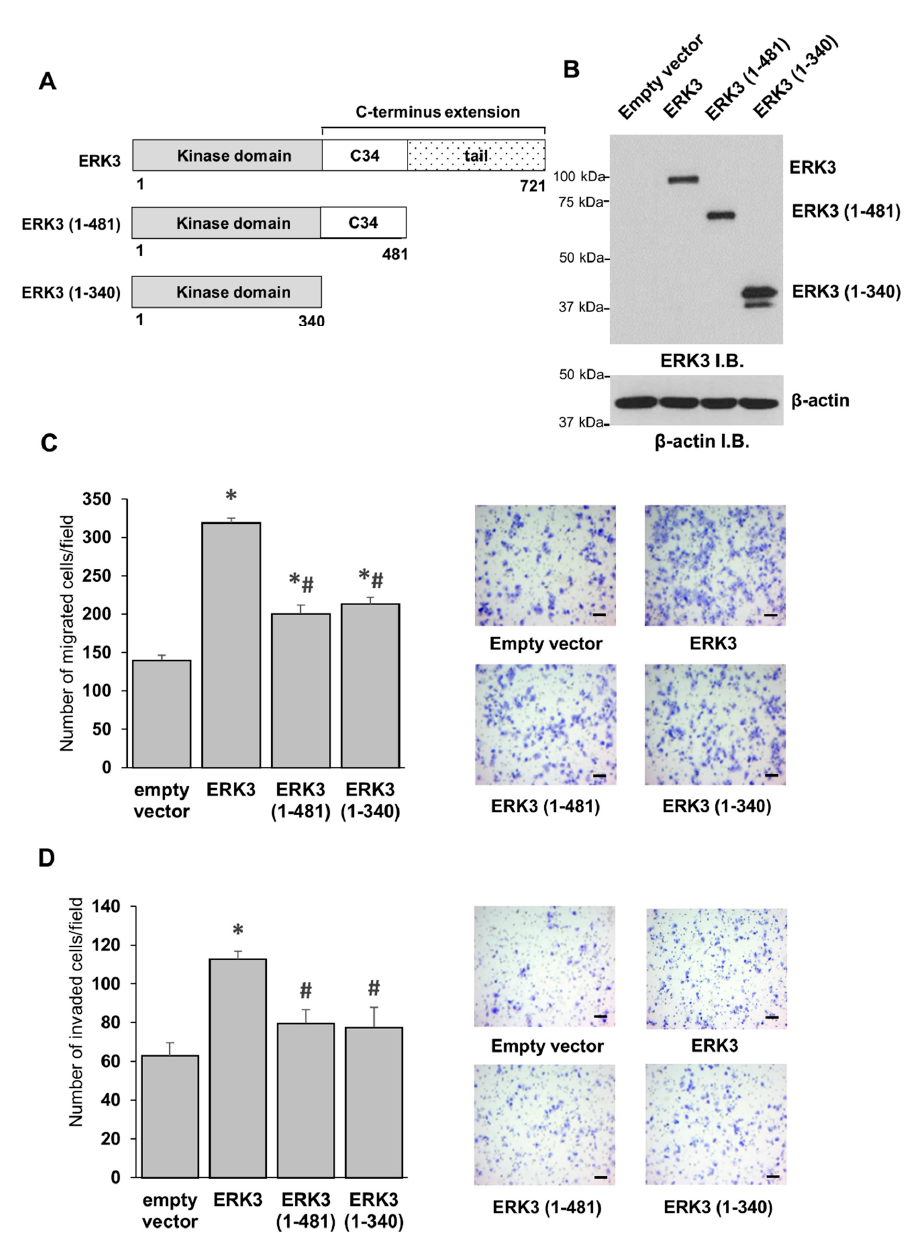
Figure 1. The C-terminus tail is important for the migration- and invasion-promoting abilities of extracellular signal-regulated kinase 3 (ERK3) in lung cancer cells. ( A ) Schematic representation of full length and deletion mutant ERK3 proteins. The conserved in ERK3 and ERK4 (C34) domain. ( B ) H1299 cells were transfected with equimolar concentrations of an empty vector, ERK3, ERK3 (1-481) or ERK3 (1-340) plasmids. Two days post-transfection, the cells were lysed and analyzed by Western blotting using an anti-ERK3 monoclonal antibody. Immunoblots (I.B.). ( C ) The migration ability of H1299 cells with the overexpression of the indicated plasmids was determined by transwell migration assay. Values in the bar graphs represent mean ± standard error (SE) ( n ≥ 6 fields). *: significantly different compared to empty vector ( p < 0.001); #: significantly different compared to ERK3 ( p < 0.0001) by one-way ANOVA. Representative images of migrated cells stained with crystal violet are shown. Scale bar, 100 µ m. ( D ) Transwell Matrigel invasion assay of H1299 cells with the overexpression of each plasmid as indicated. Values in the bar graphs represent mean ± SE ( n ≥ 6 fields). *: significantly di ff erent compared to empty vector ( p < 0.001); #: significantly di ff erent compared to ERK3 ( p < 0.05) by one-way ANOVA. Representative images of invaded cells stained with crystal violet are shown. Scale bar, 100 µ